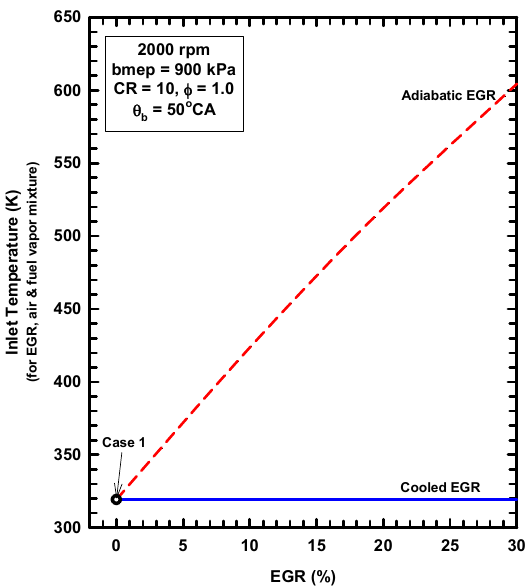
Figure 11. The inlet mixture temperature as functions of the EGR level for the two EGR configurations.